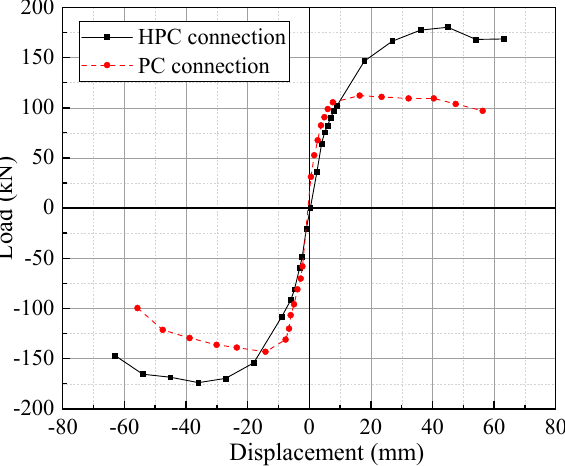
Figure 11. Envelope curves.